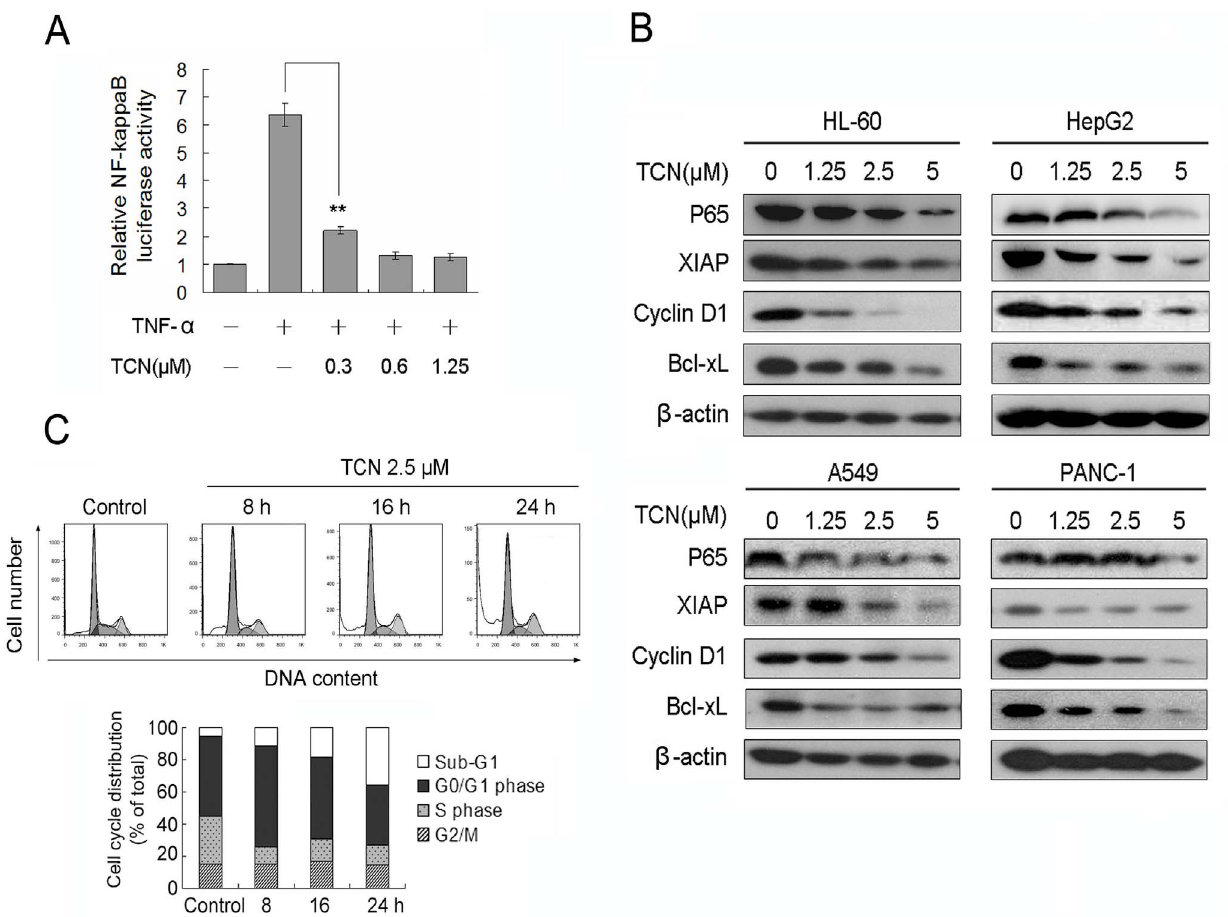
Figure 2. TCN inhibits NF- k B signaling and induces cell cycle arrest. (A) HEK 293T cells were transiently transfected with pNF- k B-Luc plasmids followed by treatment with TCN for 1 h before being stimulated with 25 ng/mL TNF- a for 18 h. (B) Lysates fromcells treated with TCN for 24 h were subjected to western blot analysis with p65, XIAP, cyclin D1 and Bcl-xL antibodies. (C) HepG2 cells were treated with 2.5 m M TCN for 8, 16 and 24 h. Cells were harvested and subjected to cell cycle analysis. The percentage of cells of different phases of cell cycle was analyzed by FlowJo. Experiments were done independently in triplicate, results are reported as means and standard deviations. Statistical significance was analyzed by One-way ANOVA, **p ,